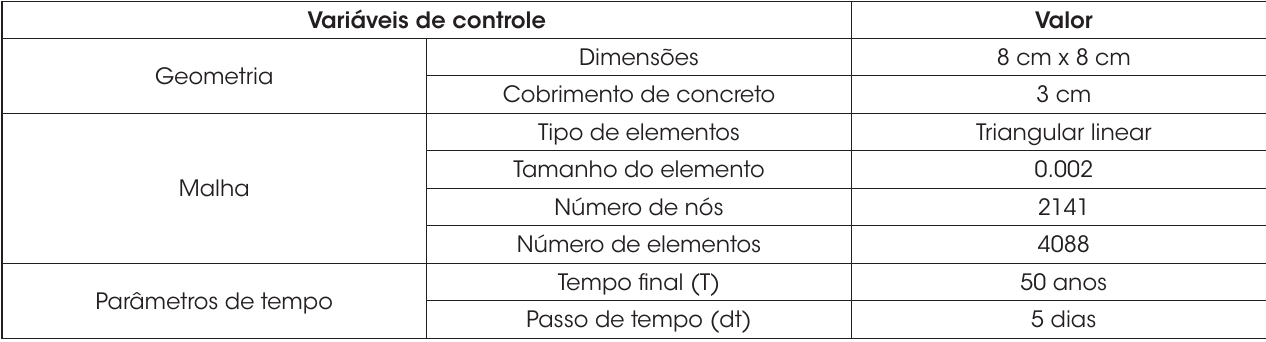
Análise paramétrica: variáveis de controle (geometria e tempo) Variáveis de